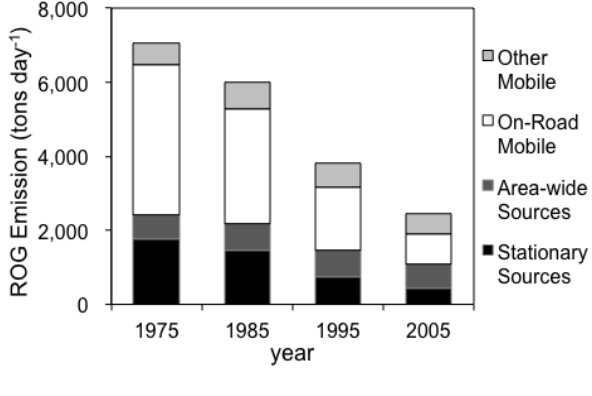
Fig. 14. Percent change in air quality, growth and emissions in Cal- ifornia (the California Air Resources Board’s (ARB’s) Emission In- ventory Branch (EIB) uses the term reactive organic gases (ROG) instead of VOCs in their analysis).